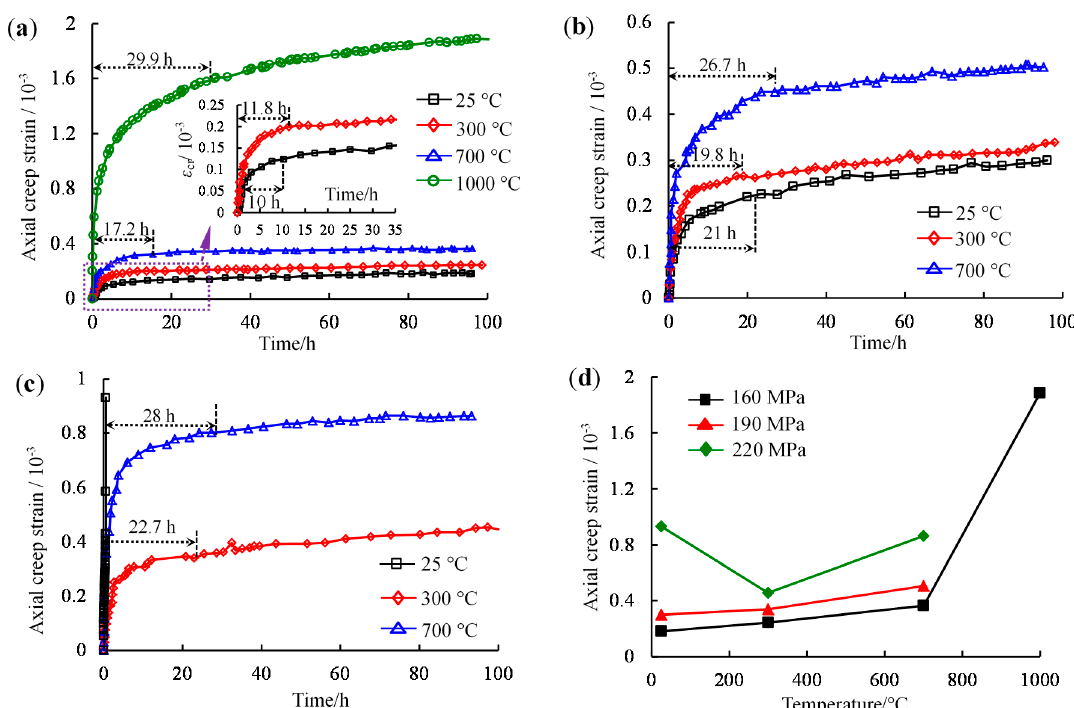
Figure 4. Axial creep strain ‐ time curves under identical stress level at different temperatures ( σ 3 = 25 MPa): ( a ) σ 1 − σ 3 = 160 MPa; ( b ) σ 1 − σ 3 = 190 MPa; ( c ) σ 1 − σ 3 = 220 MPa; ( d ) Relationship between axial creep strain and temperature.